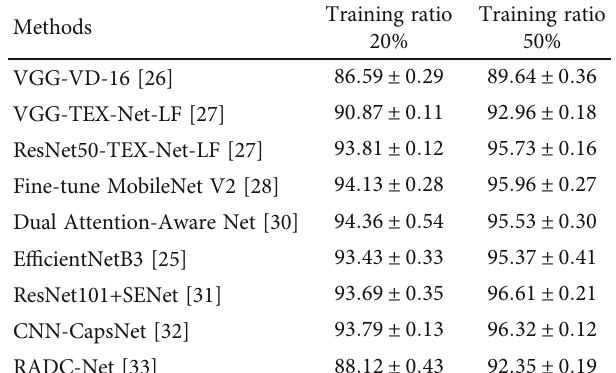
Table 5: Overall accuracy (%) comparison with other method on the AID data set.